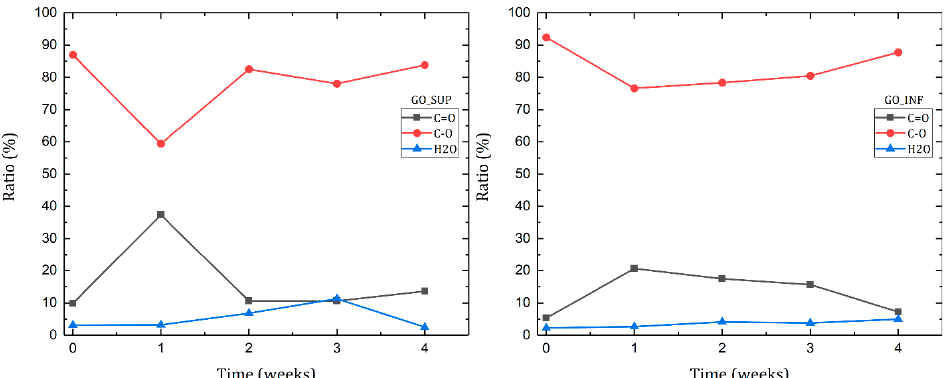
Figure 13. Evolution of the ratios of each bond type identified in the deconvoluted O1s core-level spectra of the dried GO_SUP ( left ) and GO_INF ( right ) samples over the course of the four weeks after the synthesis.